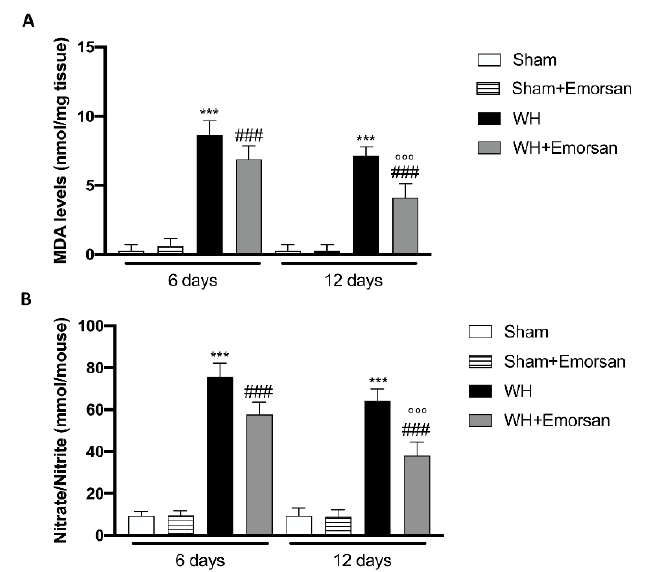
Figure 10. Effect of Emorsan ® Gel treatment on histological parameters after WH induction. WH-injured epidermis showed tissue damage, edema, and neutrophilic infiltration at both 6 days ( C , C1 ,score E ) and 12 days ( H , H1 ,score J ) compared to the sham mice ( A , A1 ,score E , F , F1 ,score J ). Emorsan® Gel treatment significantly reduced tissue injury, ameliorating histolog-ical parameters compared to the sham animals ( B ,( B1 ) histological score G ,( G1 ), score J ) at both 6 and 12 days. ( D , D1 ,score E , I , I1 ,score J ). Data are representative of at least three independent experiments. Values are means ± SEM. One-Way ANOVA test. ## p < 0.01 vs. WH; ### p < 0.001 vs. WH.